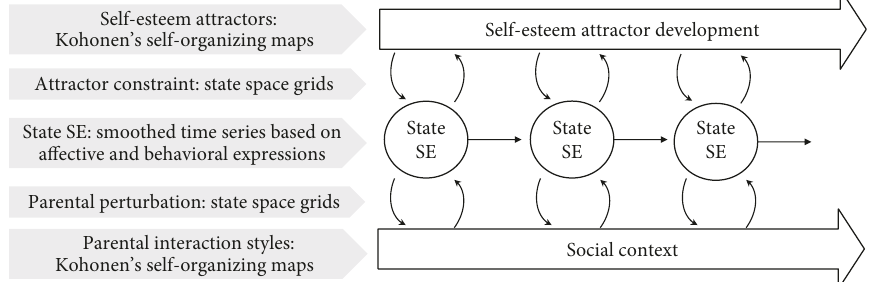
Figure 3: Overview of the methods used to capture the various processes involved in the interplay between self-esteem attractors and the immediate social context acting upon state self-esteem